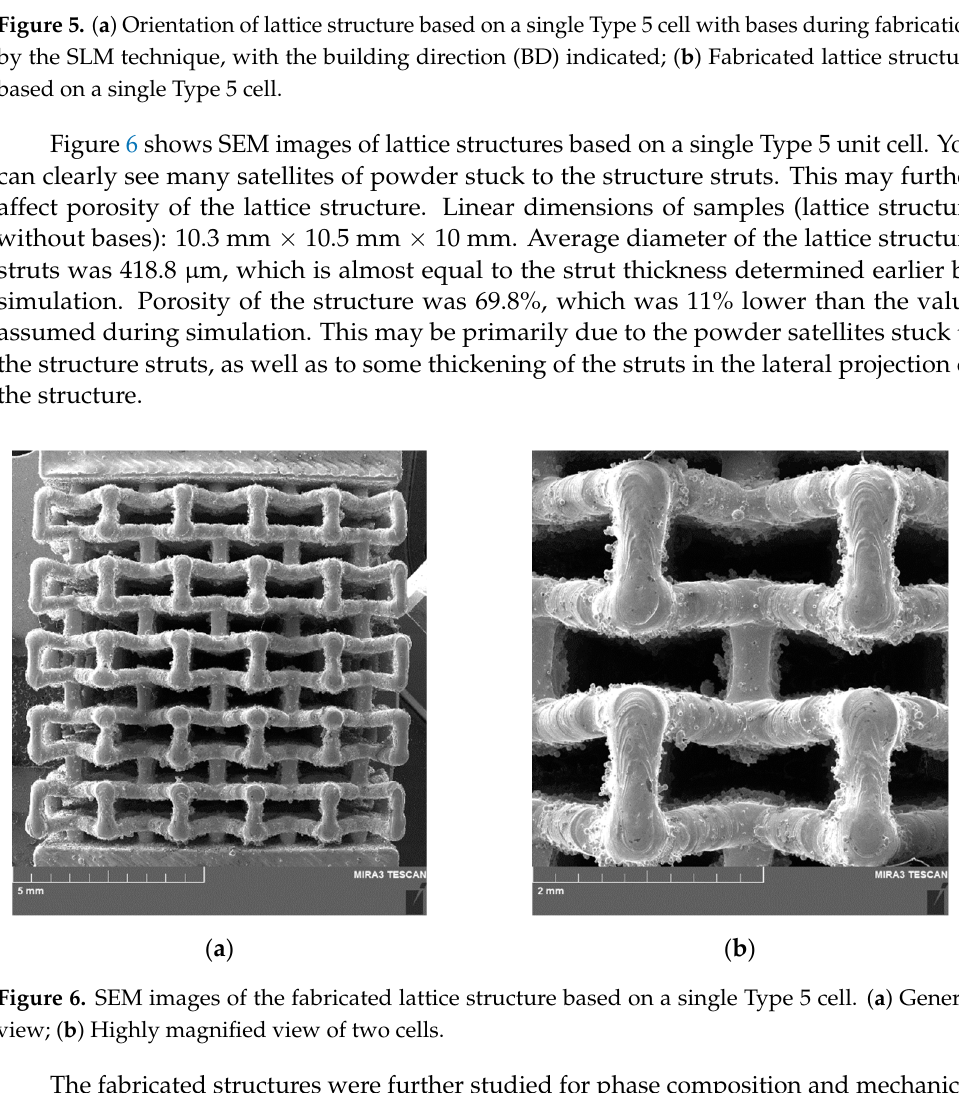
Figure 5. ( a ) Orientation of lattice structure based on a single Type 5 cell with bases during fabri ‐ cation by the SLM technique, with the building direction (BD) indicated; ( b ) Fabricated lattice structure based on a single Type 5 cell. based on a single Type 5 cell.